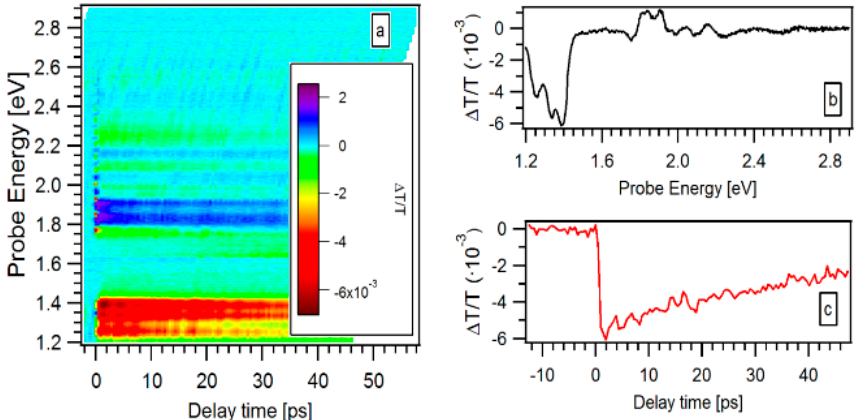
Figure 7. ( a ) Transient transmittivity ∆ T / T (E,t) collected on the 5k film with a pump photon energy of 1.63 eV and with an excitation fluence of 7.4 mJ / cm 2 . In the inset a color bar indicates the transient transmittance intensity. ( b ) Transient transmittance ∆ T / T (E,t = 5 ps) at long dynamics and ( c ) transient transmittance ∆ T / T (E = 1.36 eV,t) at fixed energy of the